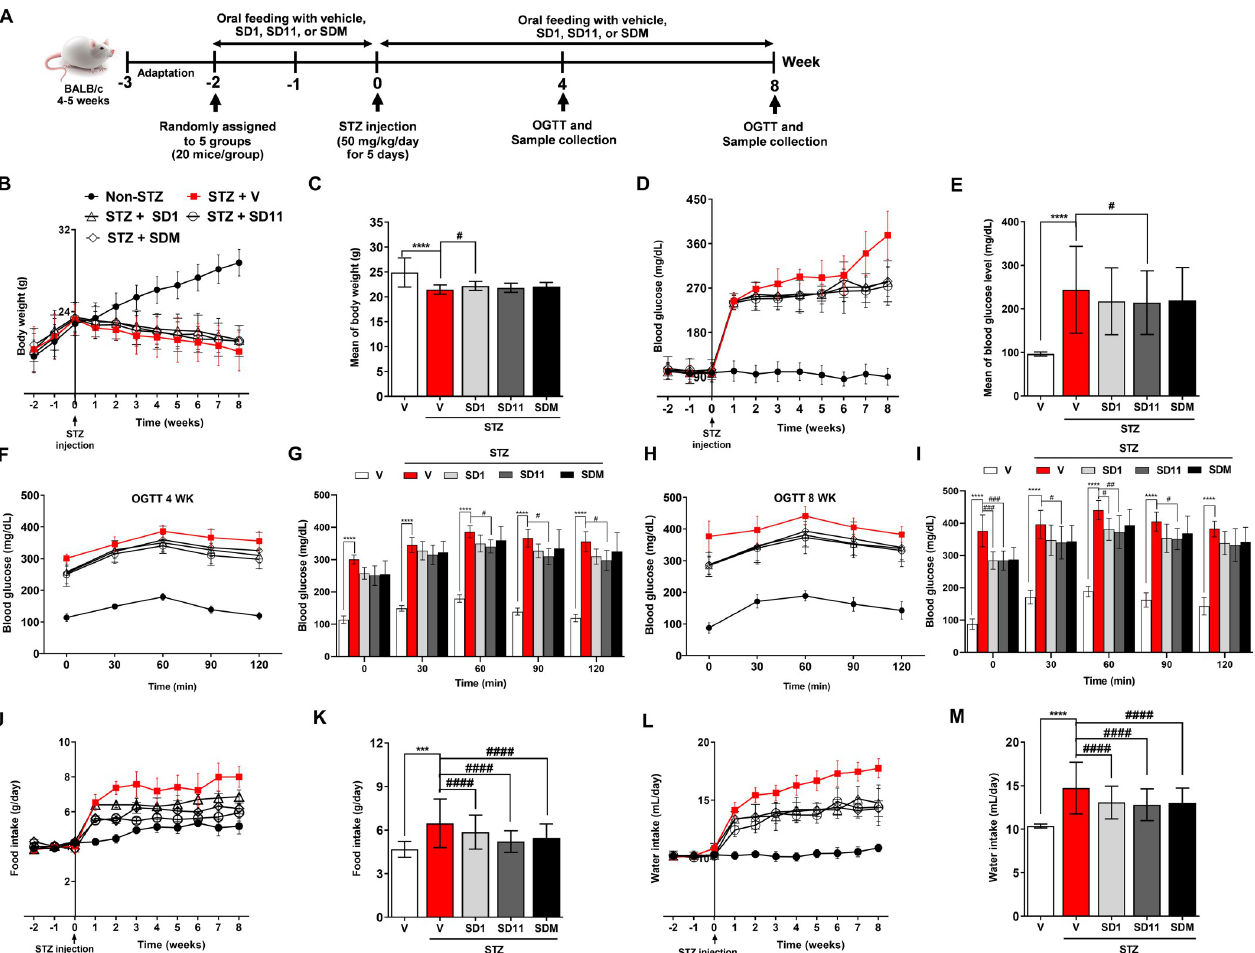
Fig 1. Probiotics ameliorate physiological and feeding behavior changes in STZ-mice. (A) Schema of the study timeline, (B) and (C) changes in body weights, (D) and (E) fasting blood glucose levels, (F) and (G) oral glucose tolerance test at 4 weeks, (H) and (I) oral glucose tolerance test at 8 weeks, (J) and (K) food intake, and (L) and (M) water intake of the experimental mice throughout the entire study (10 weeks). Values are the mean ± S.D. (n = 10 and n = 8 per group for the 4- and 8-week time points, respectively). **** P < 0.0001, *** P < 0.001 vs. the corresponding non-STZ group; #### P < 0.0001, ### P < 0.001, ## P < 0.01, # P < 0.05 vs. the corresponding vehicle-treated STZ group.